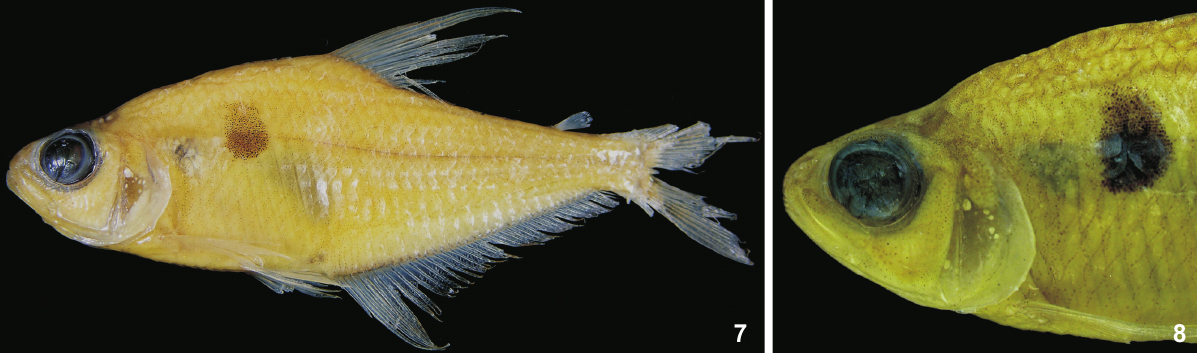
7 8 Figuras 7-8. Phenacogaster prolatus sp. nov : (7) MBUCV-V 33242, holótipo, 49,9 mm CP, afluente do caño Urami, Venezuela; (8) USNM 270337, parátipo, 48,2 mm CP, afluente do caño Chola, Venezuela, detalhe da localização da mancha umeral sobre a linha lateral.